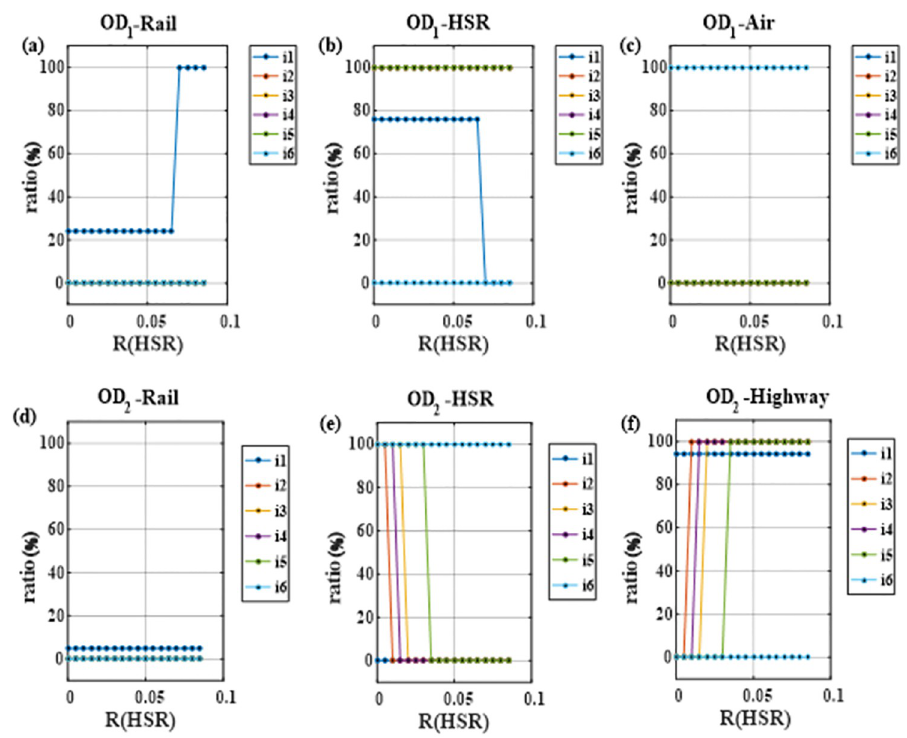
Fig 5. Influence of high-speed rail equilibrium return rate on entities’ willingness to choose various modes. (a) Passenger flow of general railway in OD1 section; (b) Passenger flow of high-speed railway in OD1 section; (c) Passenger flow of civil aviation in OD1 section; (d) Passenger flow of general railway in OD2 section; (e) Passenger flow of high-speed railway in OD2 section; (f) Passenger flow of highway in section OD2.